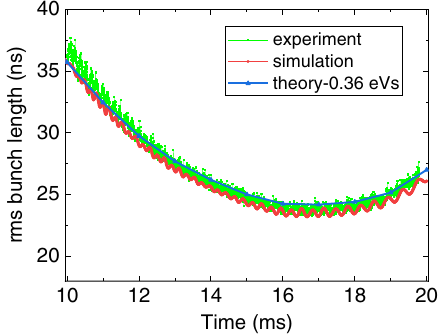
FIG. 4. Evolution of the rms bunch length from 10 ms to the extraction from the measurement (green), the theoretical calcu- lation (blue), and the ORBIT simulation (red). The theoretical bunch length is calculated based on Eq. (1) with the rms bunch area of 0.36